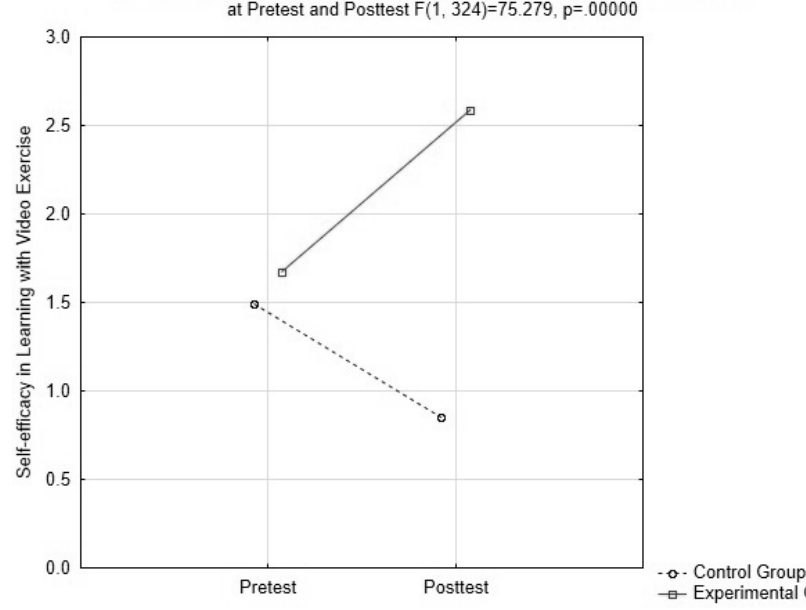
Figure 1. Distribution of the ‘Self-efficacy on learning with video exercises’ scale scores for the Experimental and Control groups at pretest and posttest.